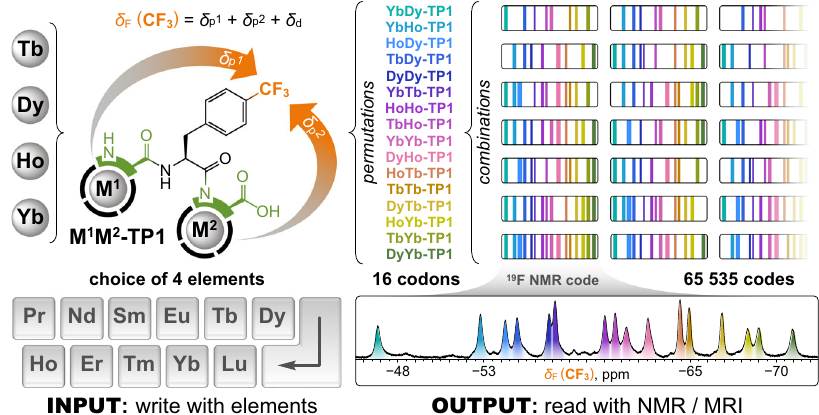
Fig. 1 The principle of paramagnetic encoding presented in this work. A sequence of two lanthanide ions (M 1 M 2 ) is chemically written into a tripeptide molecule M 1 M 2 -TP1 , which incorporates two stereochemically well-de fi ned amino acid/chelator building blocks. The paramagnetic effects of the lanthanides combine to in fl uence a reporter CF 3 group. Each M 1 M 2 permutation of the elements (codon) results in a unique 19 F NMR shift ( δ F ) that is given by the sum of individual paramagnetic shift contributions from each M 1 and M 2 ( δ p 1 and δ p 2 , respectively) and a constant diamagnetic shift ( δ d ). The encoded molecules are further multiplexed to produce codes readable by NMR or MRI. A small number of elements allows the writing of a very high number of codes. The exact chemical structures of the amino acid/chelator building blocks used in this work are provided in Figs. 2 and 3.